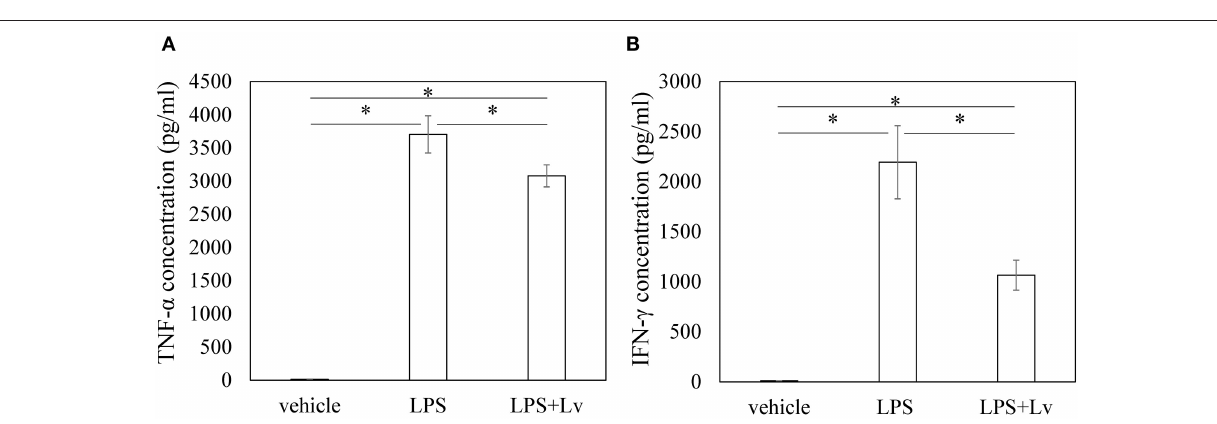
FIGURE 2 | Effect of peptide Lv on LPS-mediated TNF- α and IFN- γ production. (A) TNF- α and (B) IFN- γ protein levels in the culture supernatant of vehicle-, LPS-, and LPS + peptide Lv (LPS + Lv)-treated BMM. Values are mean ± SE ( n = 8). * p <